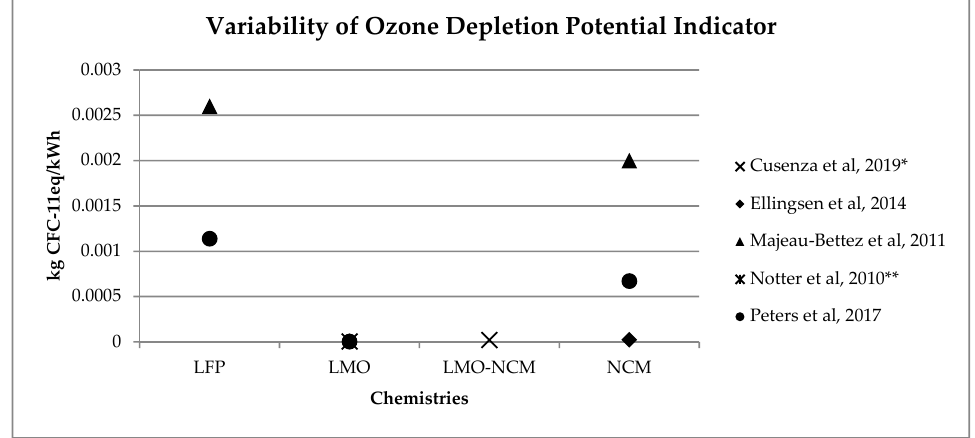
Figure 4. Variability of ozone depletion potential (kg CFC11eq/kWh) for batteries production phase (LFP: Lithium iron phosphate; LMO: Lithium Manganese Oxide; LMO-NCM: Lithium Manganese Oxide-Lithium Nickel Cobalt Manganese; NCM: Lithium Nickel Cobalt Manganese Oxide); * data from reference [7] are calculated on the basis of the total amount and the percentage for battery production, ** data from reference [11] have been updated using Ecoinvent v.